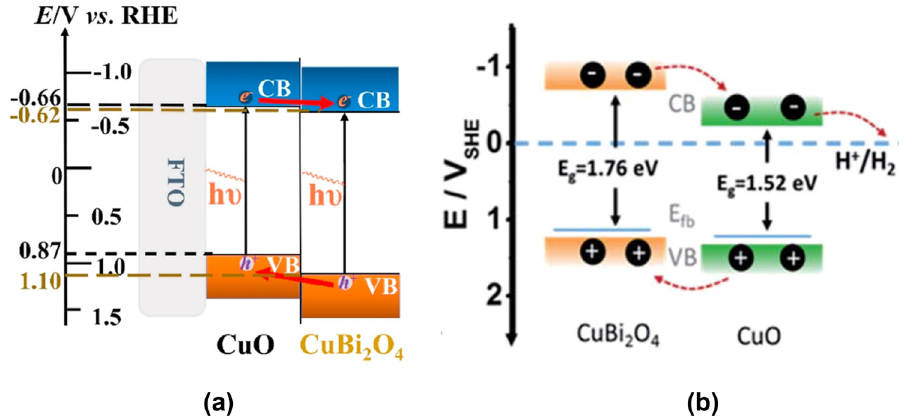
Figure 12: Proposed energy band alignments of the CuBi 2 O 4 /CuO heterojunction: ( a ) electron moves from CuO to CuBi 2 O 4 to electrolyte ( Reprinted with permission from ref. [ 184 ] . Copyright © 2021, Elsevier ) and ( b ) electron moves from CuBi from ref. [ 185 ] . Copyright © 2020, Royal Society of Chemistry )